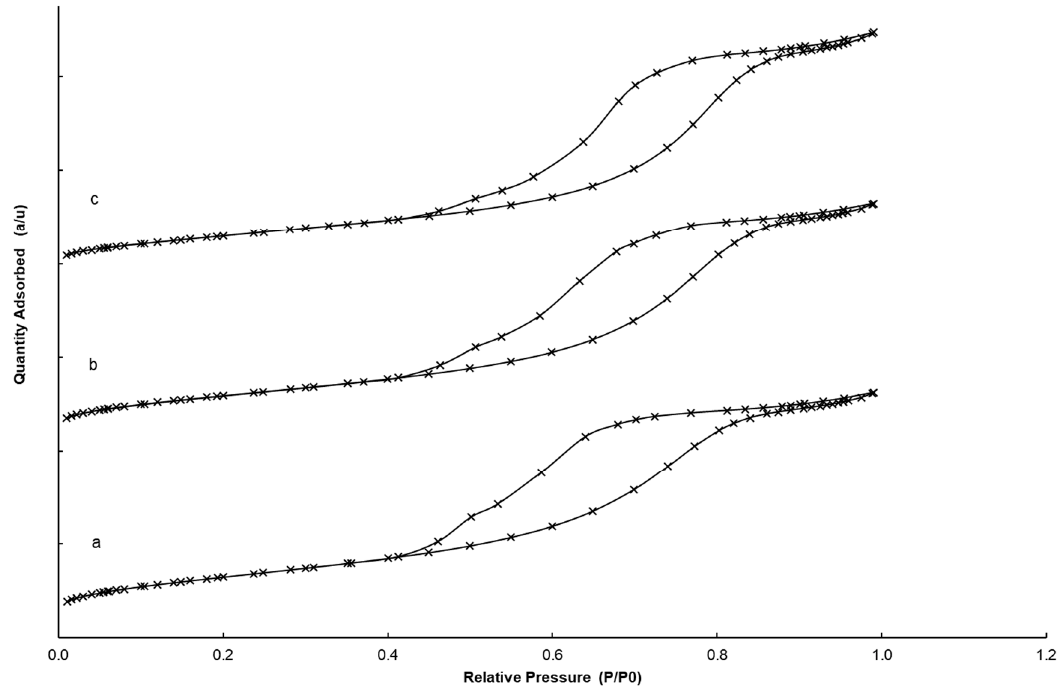
Figure 1. N 2 adsorption–desorption isotherms of the catalysts. ( a ) Ag1Z, ( b ) Ag5Z and ( c ) Ag10Z.